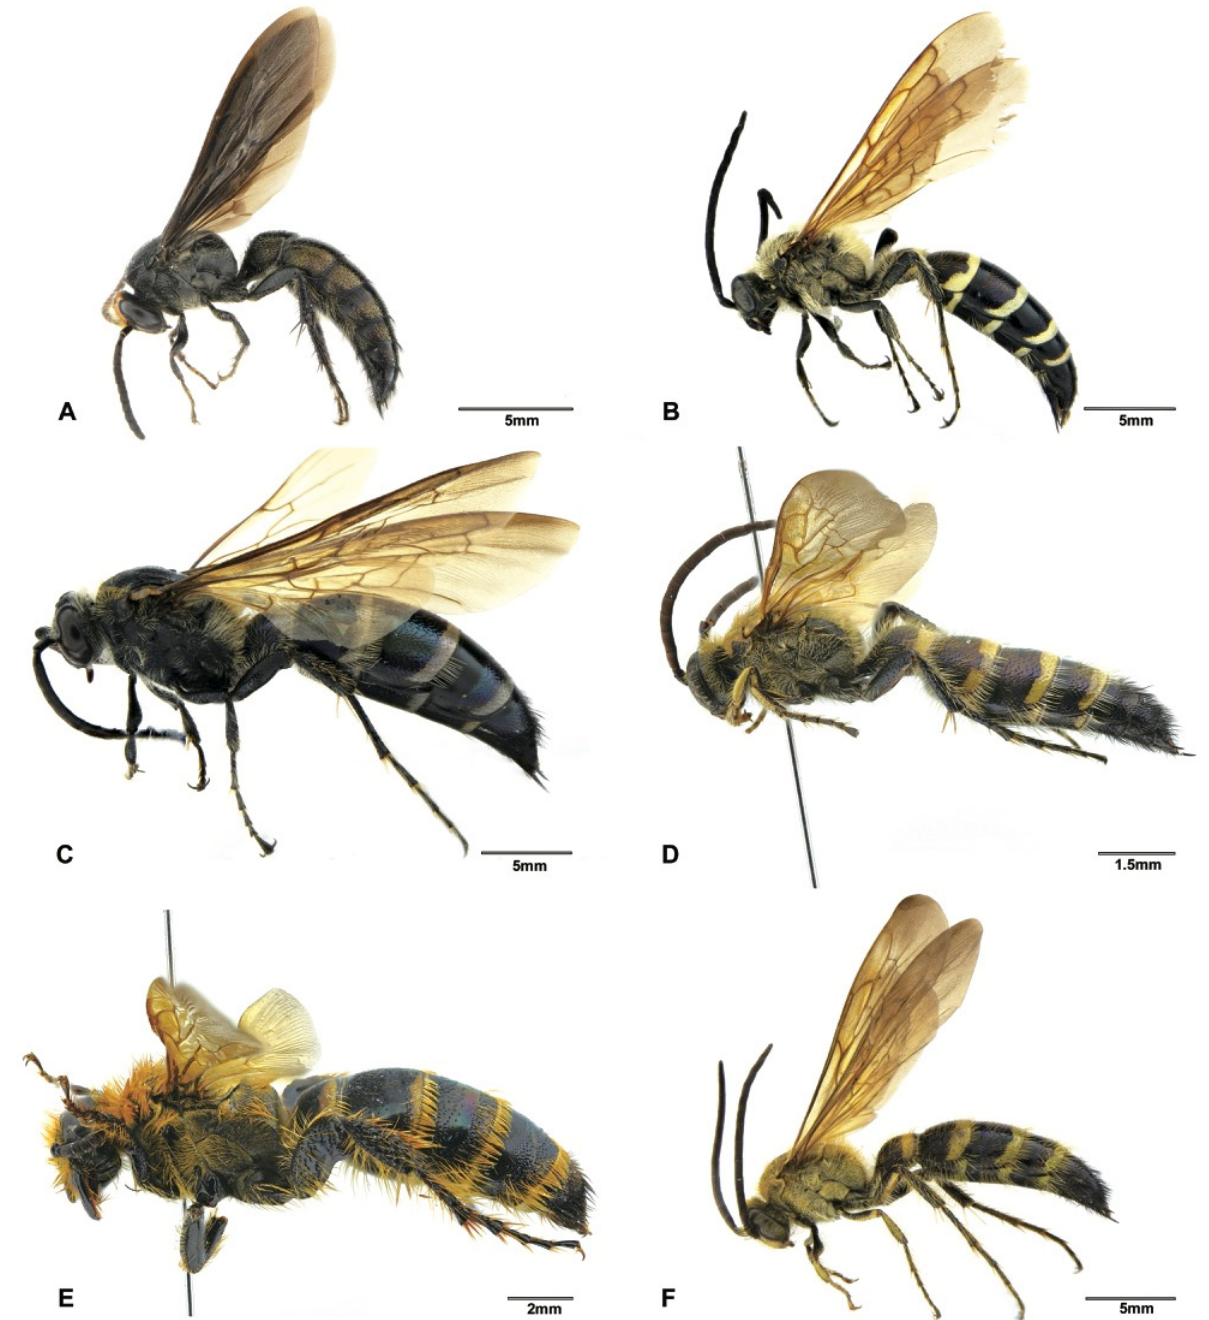
Figure 5. Habitus, lateral view. ( A ) Scolia sp., male (SCAU3043674); ( B ) Megacampsomeris asiatica (Saussure, 1859), male (SCAU3043656); ( C ) Megacampsomeris binghami (Betrem, 1928), male (SCAU3043660); ( D ) Megacampsomeris farrenwhitei Betrem, 1928, male (SCAU3043654); ( E ) Megacampsomeris farrenwhitei Betrem, 1928, female (SCAU3043653); ( F ) Megacampsomeris prismatica (Smith, 1855), male (SCAU3048015).